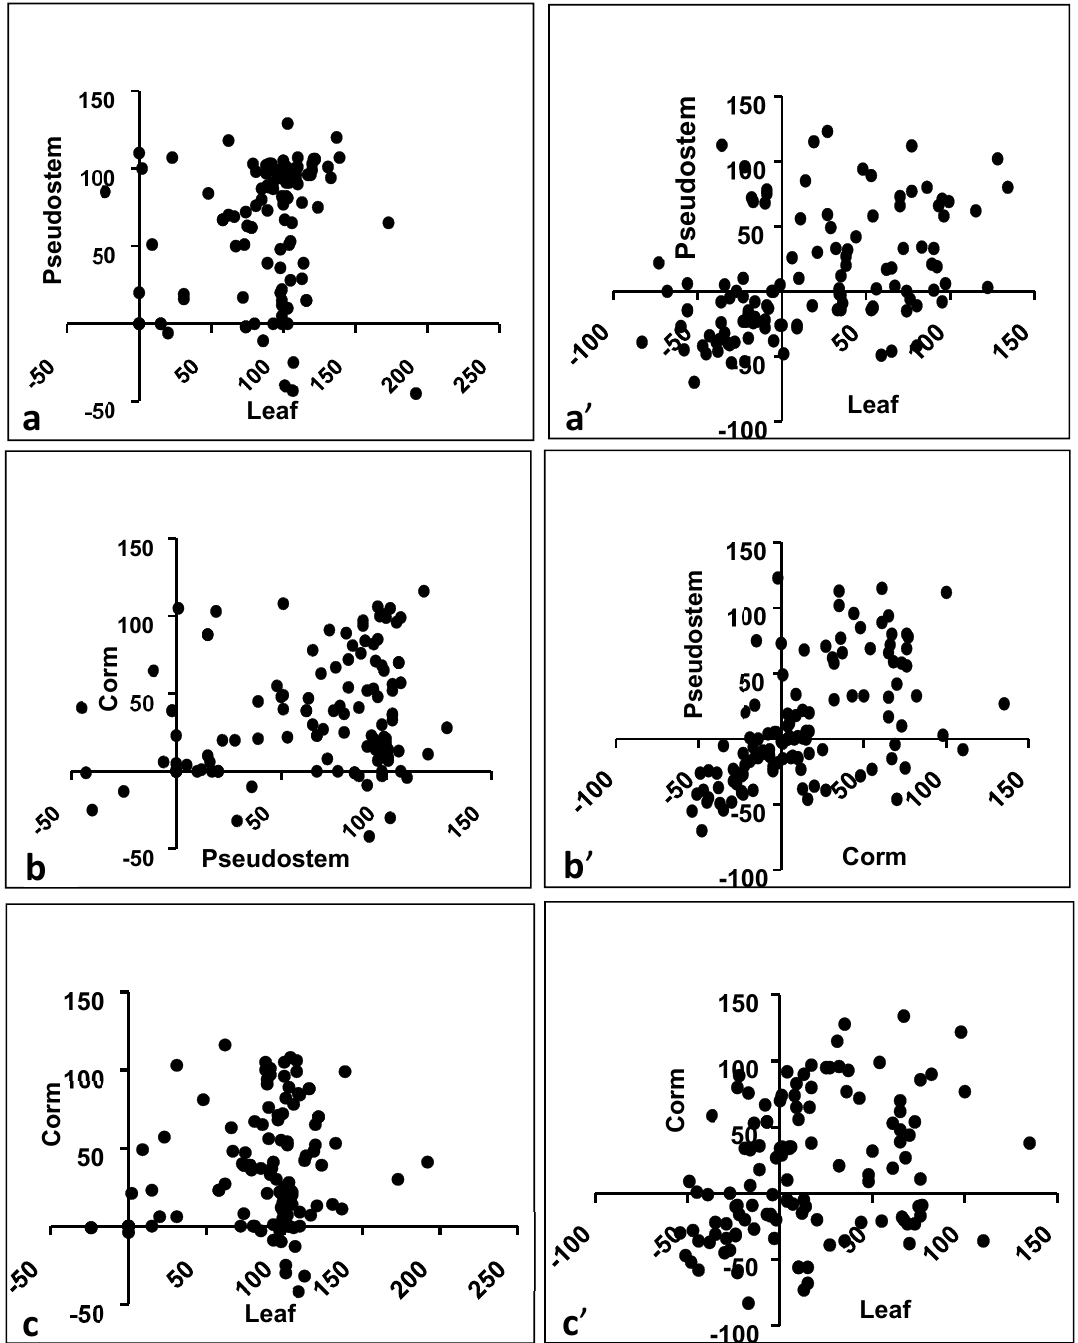
Figure 4. Correlation between di ff erent plant parts. ( a ) Leaf vs. Pseudostem (Gram-positive), ( a ’) Leaf vs. Pseudostem (Gram-negative), ( b ) Pseudostem vs. Corm (Gram-positive), ( b ’) Pseudostem vs. Corm (Gram-negative), ( c ) Leaf vs. Corm (Gram-positive), ( c ’) Leaf vs. Corm (Gram-negative)